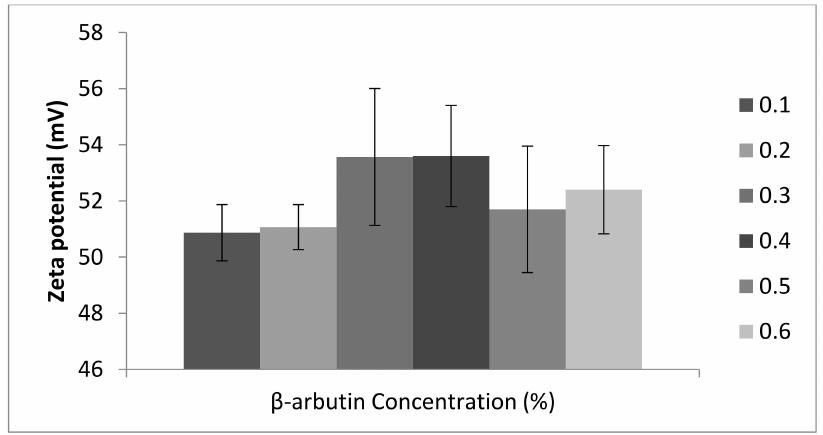
Figure 3. Zeta potential of 0.1%, 0.2%,0.3%,0.4%, 0.5%, and 0.6% β -arbutin CSNPs. ( n = 3). No significance difference among all subsets.